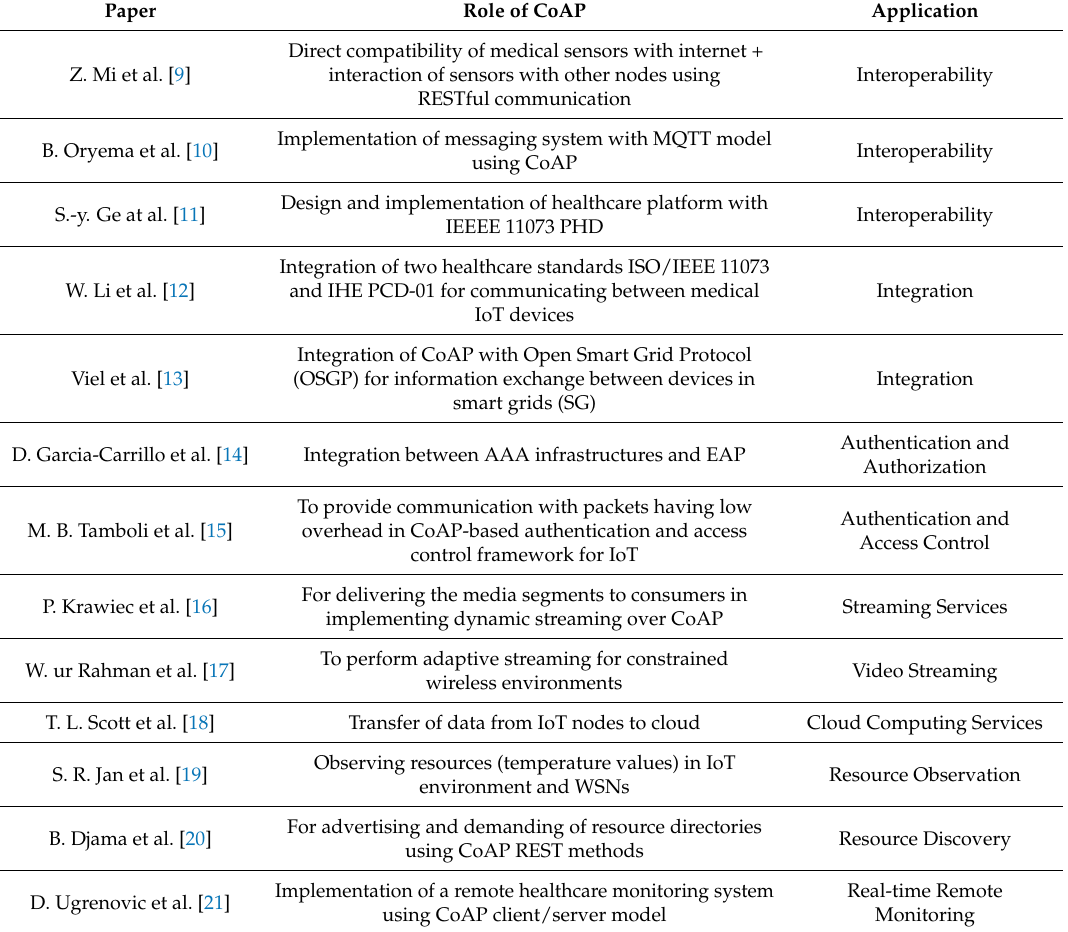
Table 1. Applications of